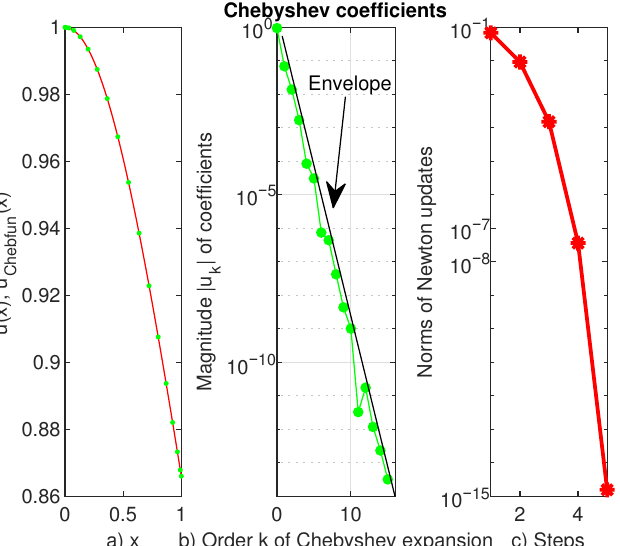
Figure 1. ( a ) The exact solution (5) (green dots) and Chebfun solution (6) to problem (4) are displayed. ( b ) In a log-linear plot the behaviour of | u k | Chebyshev coefficients of solution to problem (4) (green dots) is reported. The envelope is depicted by a black straight line. ( c ) This panel shows that Newton’s method is of second order and uses five iterative